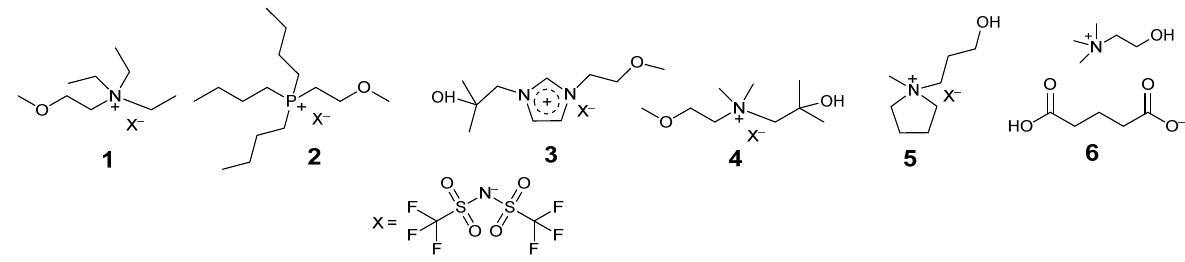
Figure 5. Representative examples ( 1 – 6 ) of functionalized ionic liquids for enzyme studies.